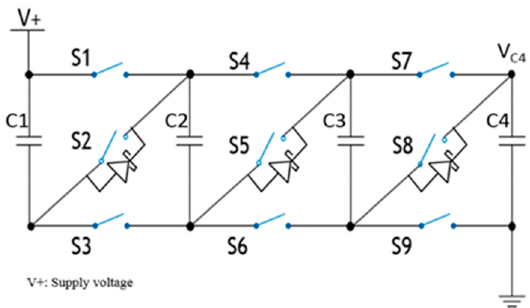
Figure 2. Electrical schematic of the reference self-adaptive switched architecture with 4 UCs (V+ = V IN = V OUT ).